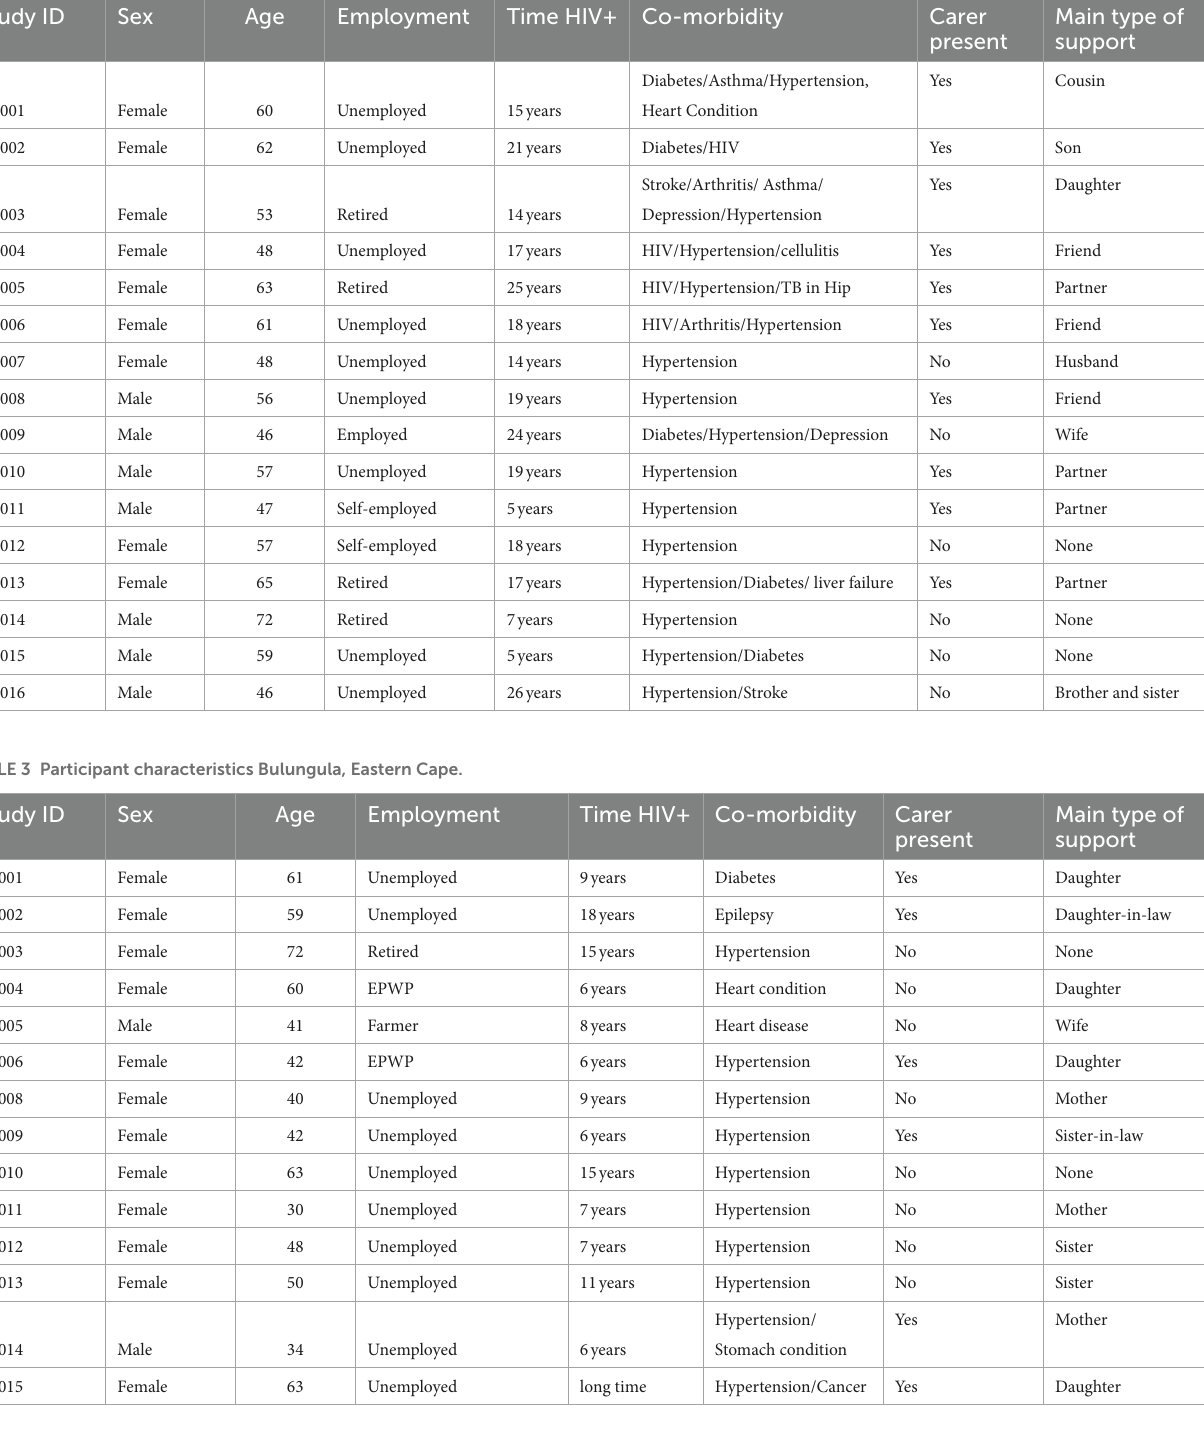
TABLE 2 Participants characteristics Gugulethu, Cape Town.